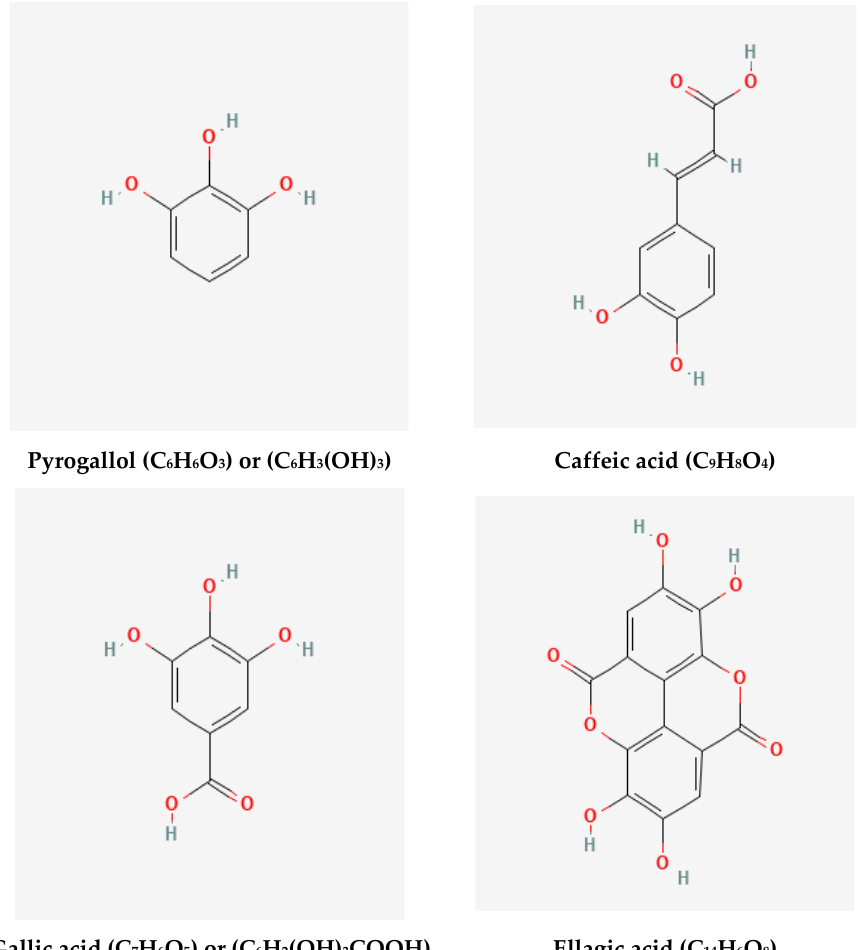
Figure 4. Chemical structures of the HPLC-detected phenolics in GB leaves (https://pub- chem.ncbi.nlm.nih.gov), accessed on 15 April 2022. nlm.nih.gov), accessed on 15 April